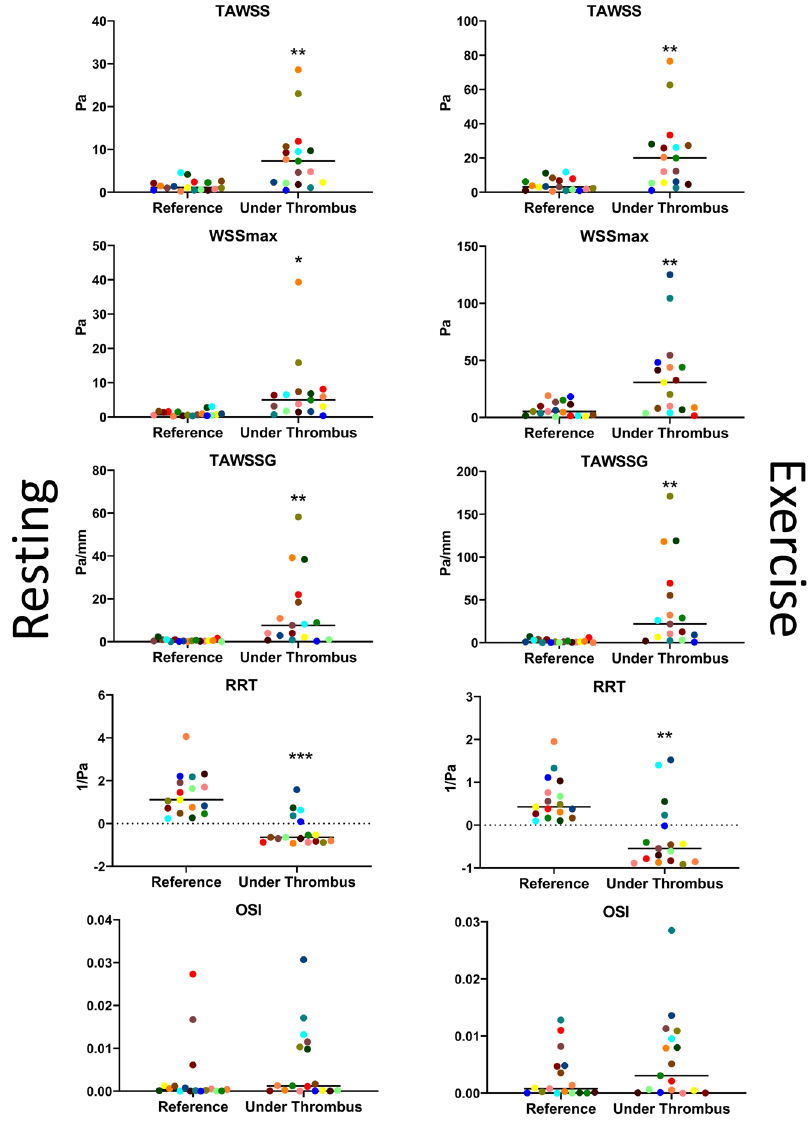
Figure 1. CFD analysis of artery wall underlying adherent thrombi. CFD was used to calculate the spatially averaged TAWSS within a non-diseased area and under the thrombus (n = 17) identifying a significant elevation of TAWSS, the median value is displayed on the graph (*p < 0.05, **p < 0.01, ***p < 0.001 paired T-test). No significant difference in OSI was observed between